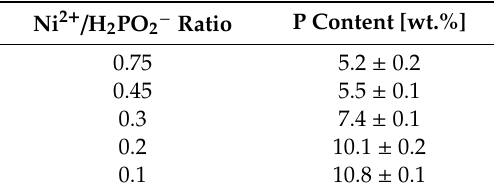
Table 2. The phosphorus content of electroless nickel (Ni–P) as-deposited and heat-treated coatings in dependence on the Ni 2 + / H 2 PO 2 − ratios, energy-dispersive spectroscopy